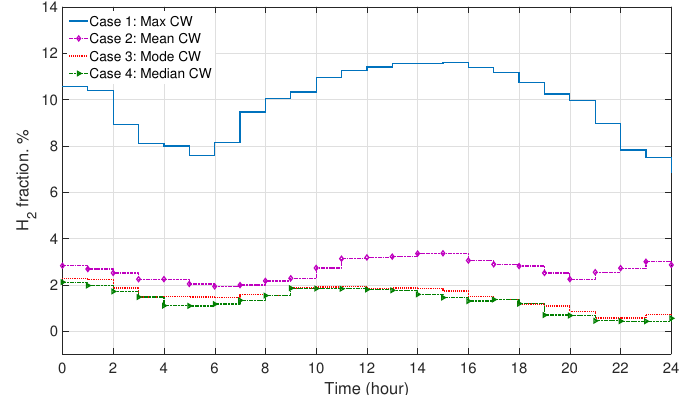
Figure 9. Hydrogen concentration at node 5 after blending with the